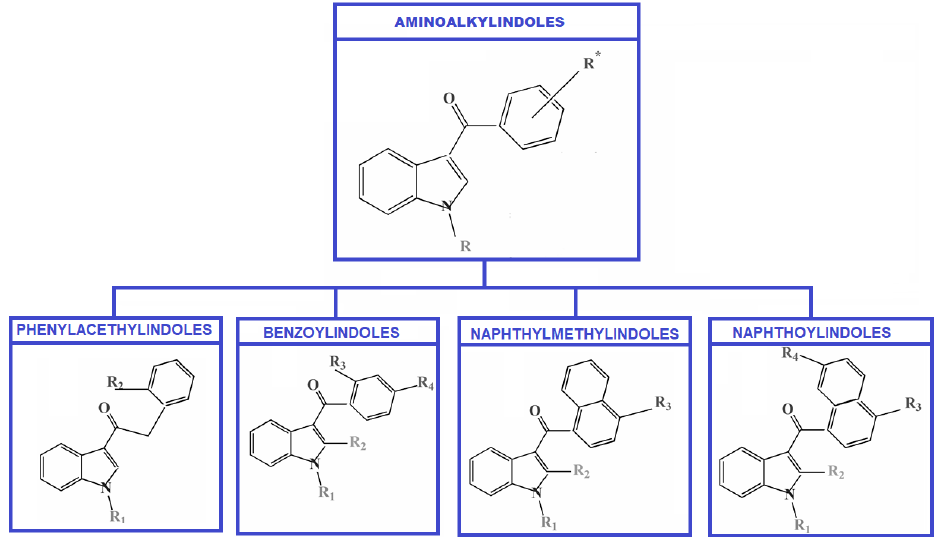
Figure 1. Classification of Aminoalkylindoles—four